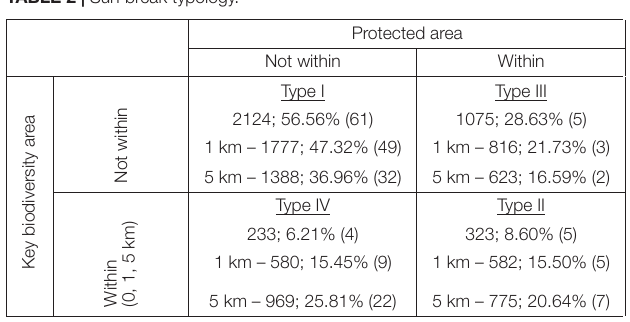
TABLE 2 | Surf break